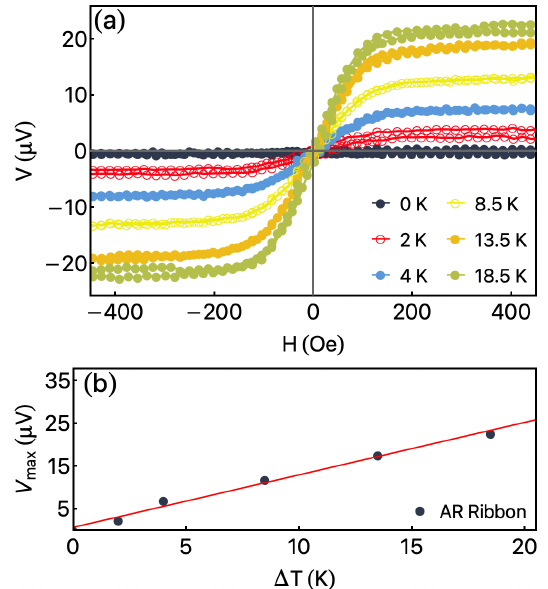
Figure 7. Anomalous Nernst Effect measurement for AR ribbon. ( a ) ANE voltage as a function of external magnetic field for distinct ∆ T values. ( b ) V max as a function of ∆ T for AR